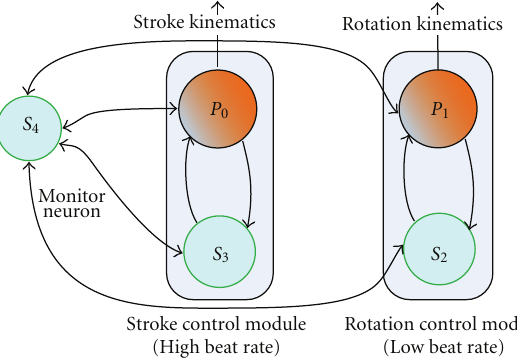
Figure 18: The output state dynamics of each neuron in the interfrequency group amputated network, amputated as part of the lesion study on the reduced five-neuron network. It can be observed that the primary stroke neuron and the third secondary neuron produced perfect in sync oscillations forming a two-neuron independent oscillator. On the other hand, the primary rotation neuron with second neuron formed a feeble two neuron oscillator. It should be noticed that the fourth neuron dynamics are saturated, in the amputated network, compared to its original oscillatory behavior seen in Figure 16 of the fully connected reduced controller.